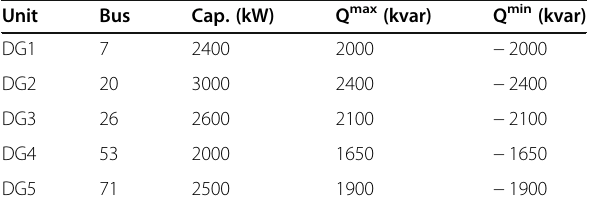
Table 1 Required information about the DGs